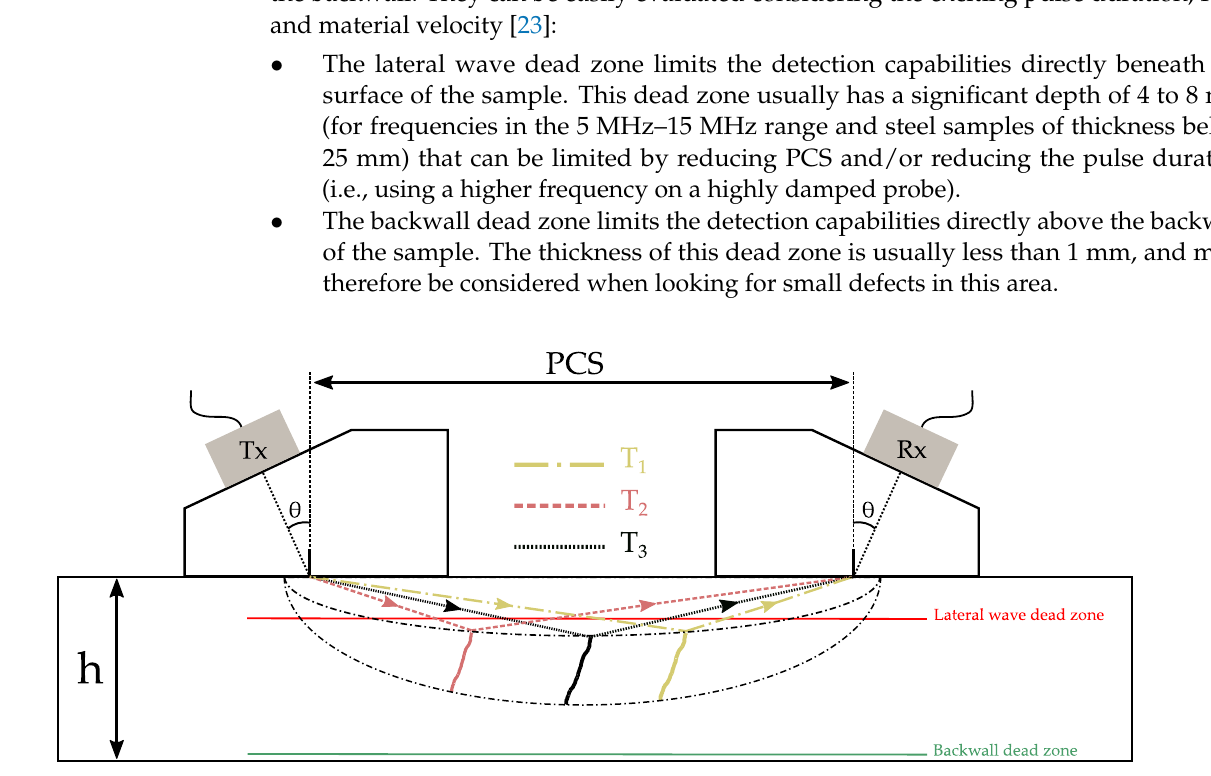
Figure 2. Dead zones of time of flight diffraction (TOFD) related to the ring time near the surface (lateral wave dead zone) and the backwall (backwall dead zone). Locus curve (dotted line) showing three possible defect locations for the exact same times of flight ( 𝑇 1 , 𝑇 2 , and 𝑇 3 ).